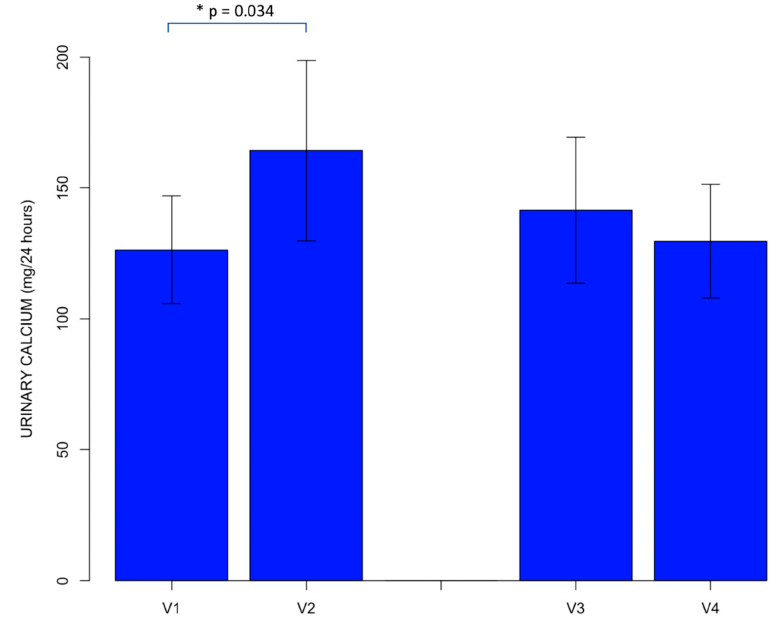
Figure 2. Comparisons between the mean value of 24 h urinary calcium at baseline, before consumption of the calcium-rich water (V1), and the mean value of 24 h urinary calcium after the 3 week period of intake of the calcium-rich water (V2), and between the mean value of 24-h urinary calcium under basal conditions, at the end of the “wash-out” phase, before starting intake of water B (V3), and the mean value of 24 h urinary calcium at the end of the 3 week period of intake of water B (V4), after excluding urinary calcium values according to the preliminary verification. The error bars indicate the standard error of mean. * = statistical significance.